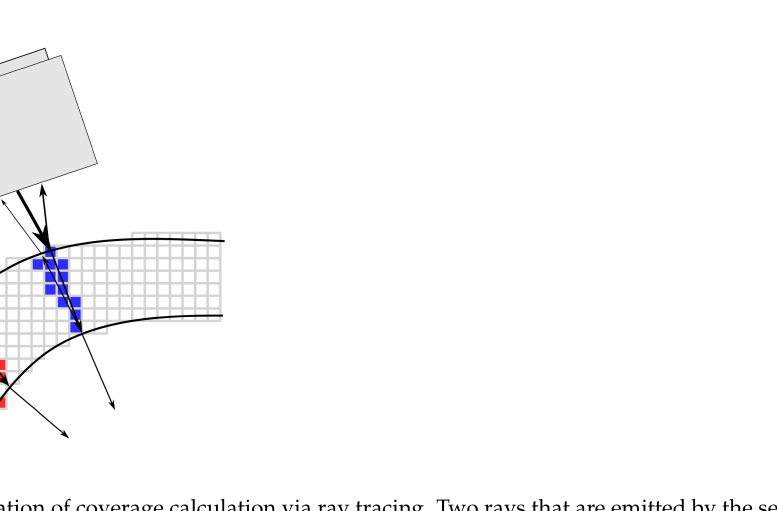
Figure 3. Illustration of coverage calculation via ray tracing. Two rays that are emitted by the sensor are shown. At any surface, transmission and reflection occur. Hence, each ray spans a tree. Voxels that are traversed by rays are shown in color. Red voxels correspond to a tree of rays that do not return to the sensor—at least not within the first four levels of the tree. Blue voxels are covered by rays that return back to the sensor. In contrast to red voxels, we consider blue voxels to be covered.